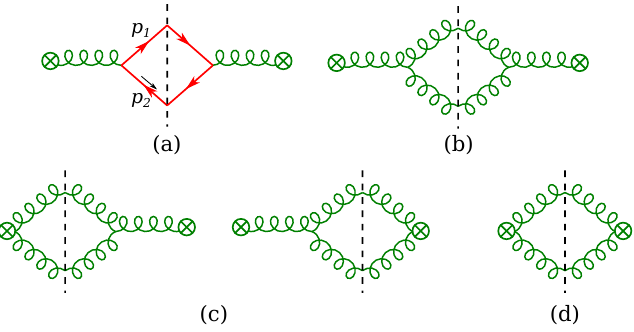
Figure 3. One-loop diagrams contributing to the gluon jet functions. The ⊗ denotes the collinear gluon field B µ (dressed with Wilson n ⊥